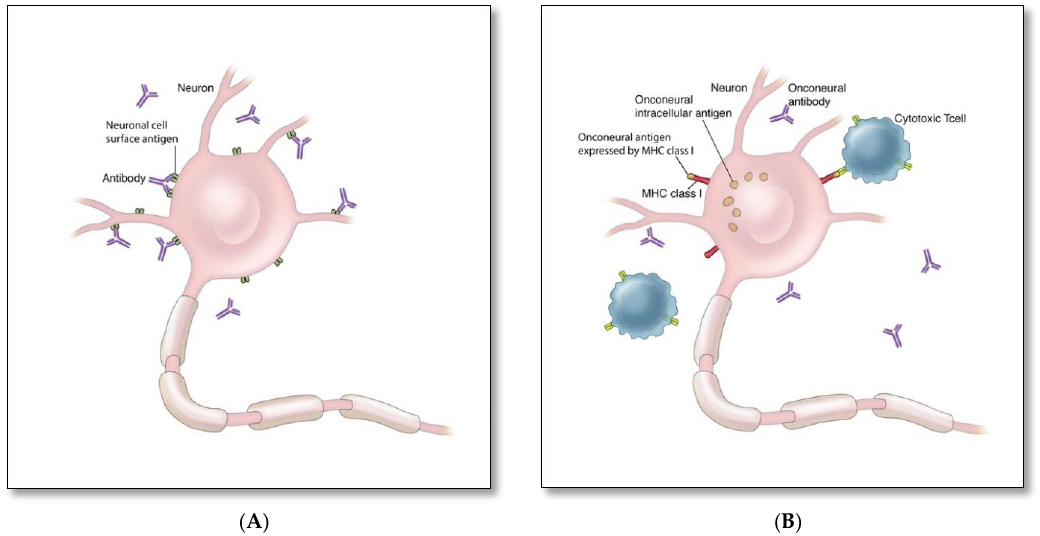
Figure 1. Mechanisms of autoimmune encephalitis: ( A ) Autoimmune encephalitis associated with antibodies against synaptic surface proteins (e.g., NMDAR, LGI1, AMPAR) [8], ( B ) Autoimmune encephalitis associated with antibodies against intracellular cytoplasmic (e.g., Yo, CV2/CRMP5) or nuclear (e.g., Hu, Ri) onconeural antigens [9 – 11].